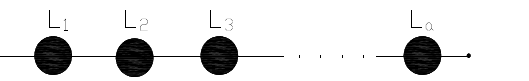
Figure 1. Line of transmission with a series-connected